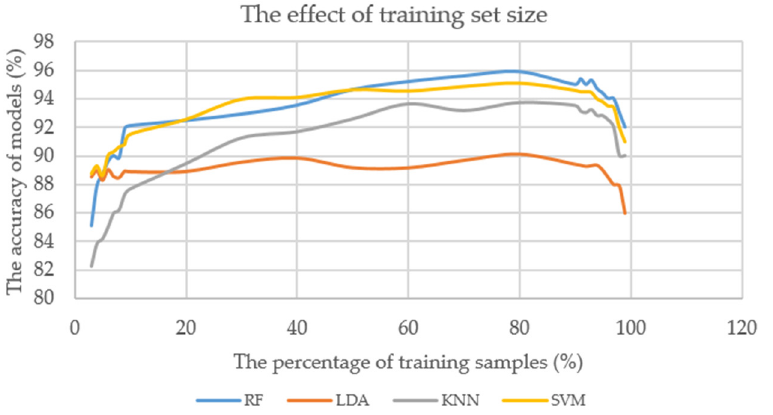
Figure 16. The accuracy of models based on training set size.